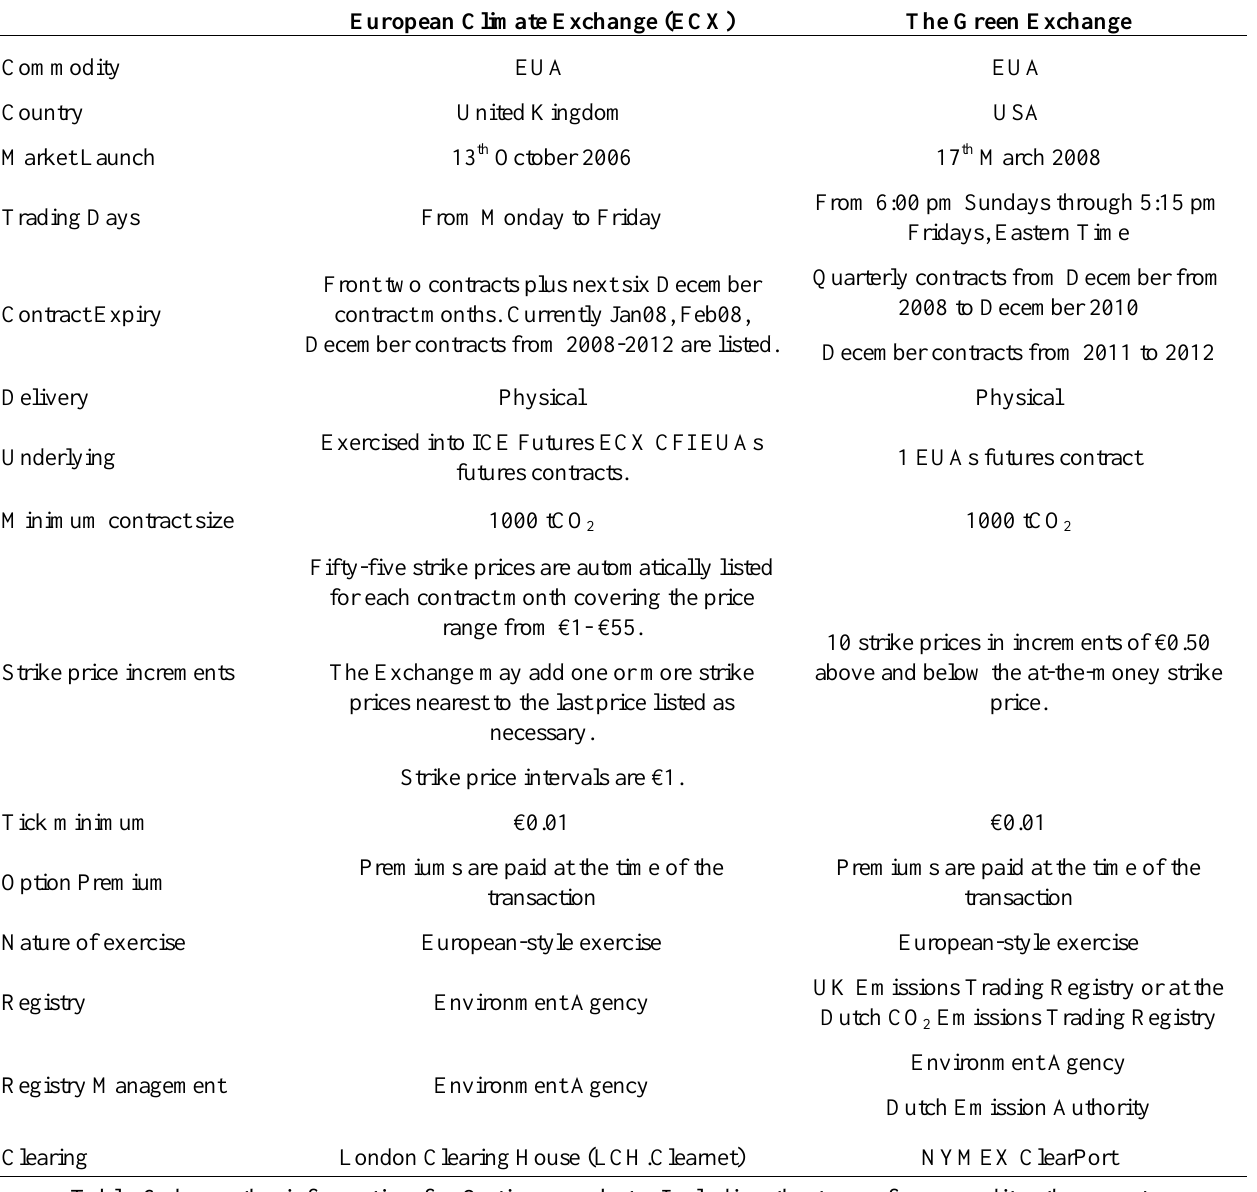
Table 6. Options Trading Rules Details in Organized